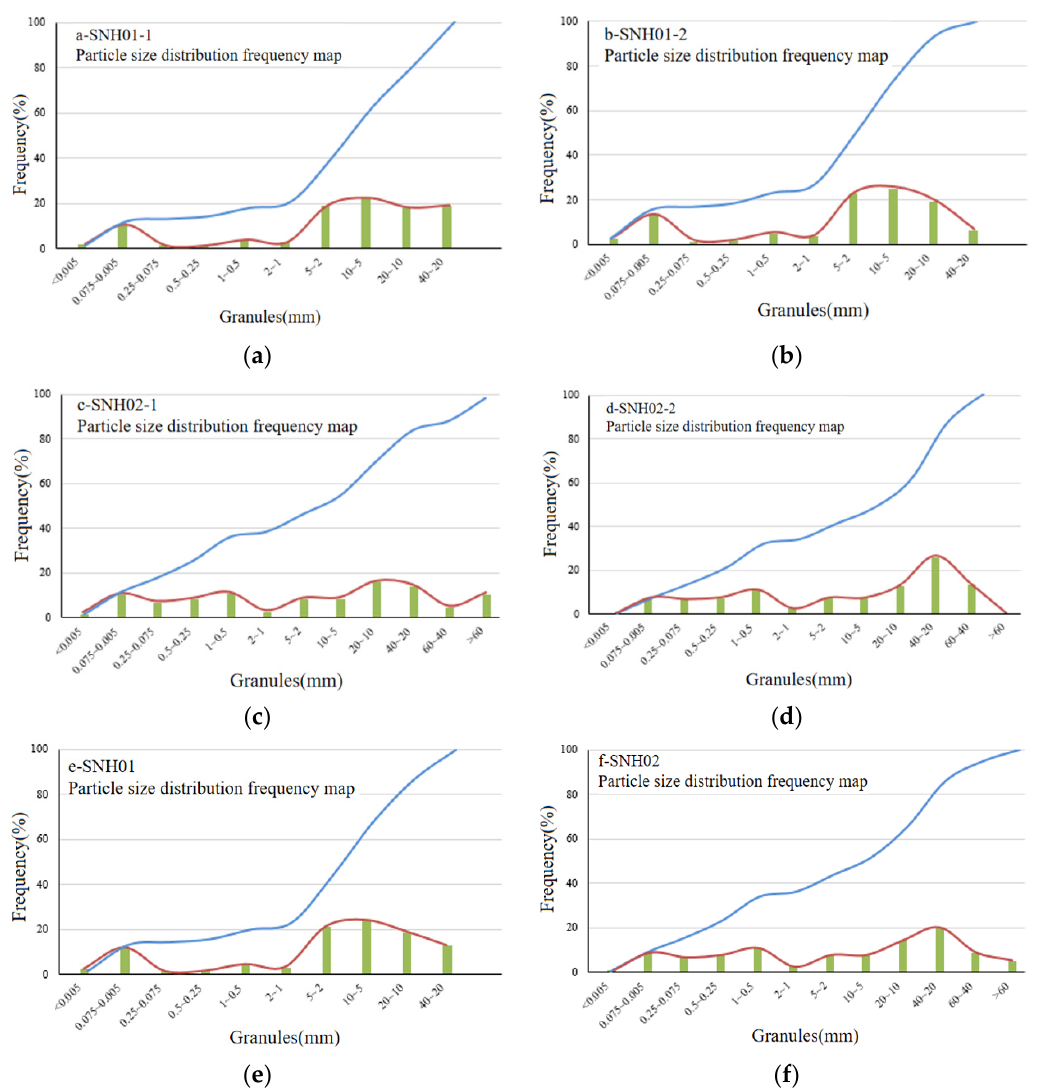
Figure 11. Particle size profile of glacial lake soil sample (a), SNH01-1, (b), SNH01-2, (c), SNH02-1, (d), SNH02-2, (e), SNH01, (f), SNH02.